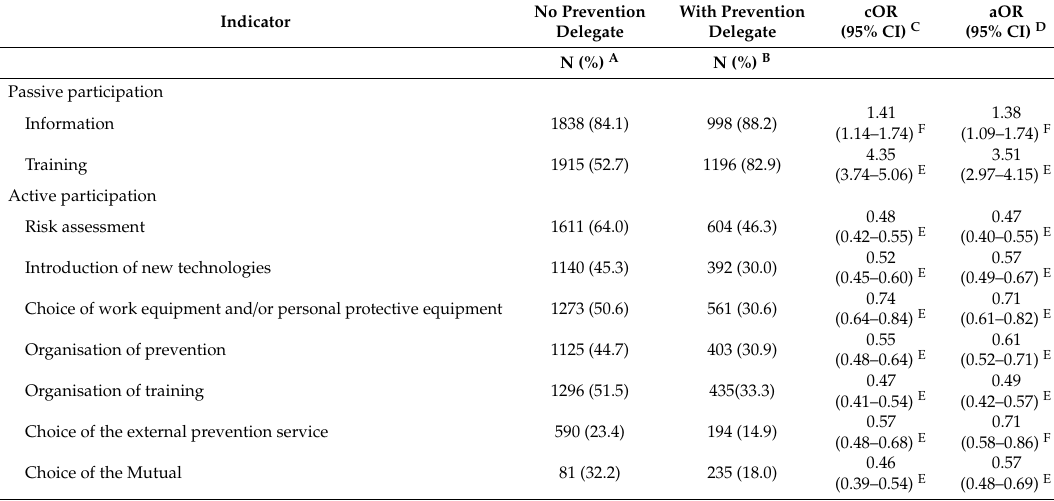
Table 4. Prevalence and logistical regressions adjusted between the presence of unitary prevention delegates and participatory management